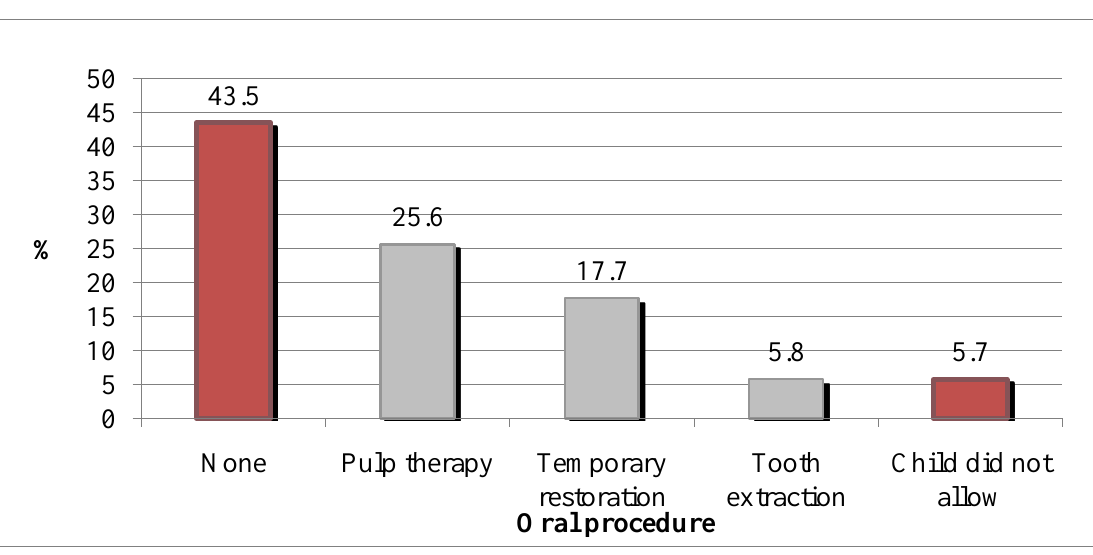
Figure 1. Frequency of procedures performed on preschoolers with toothache in community dental emergency services (nine cases excluded due to missing